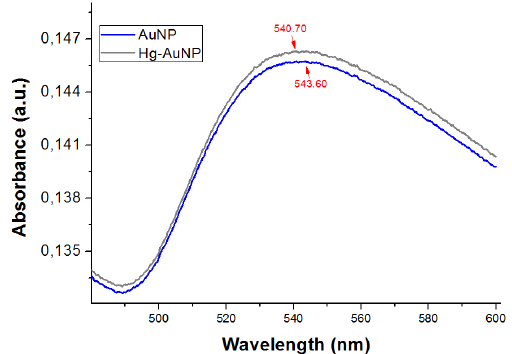
Figure 4. UV–vis spectra of AuNPs/TiO 2 nanofibers before (blue) and after a 15min exposure to 2ppm of Hg 0 (gray).